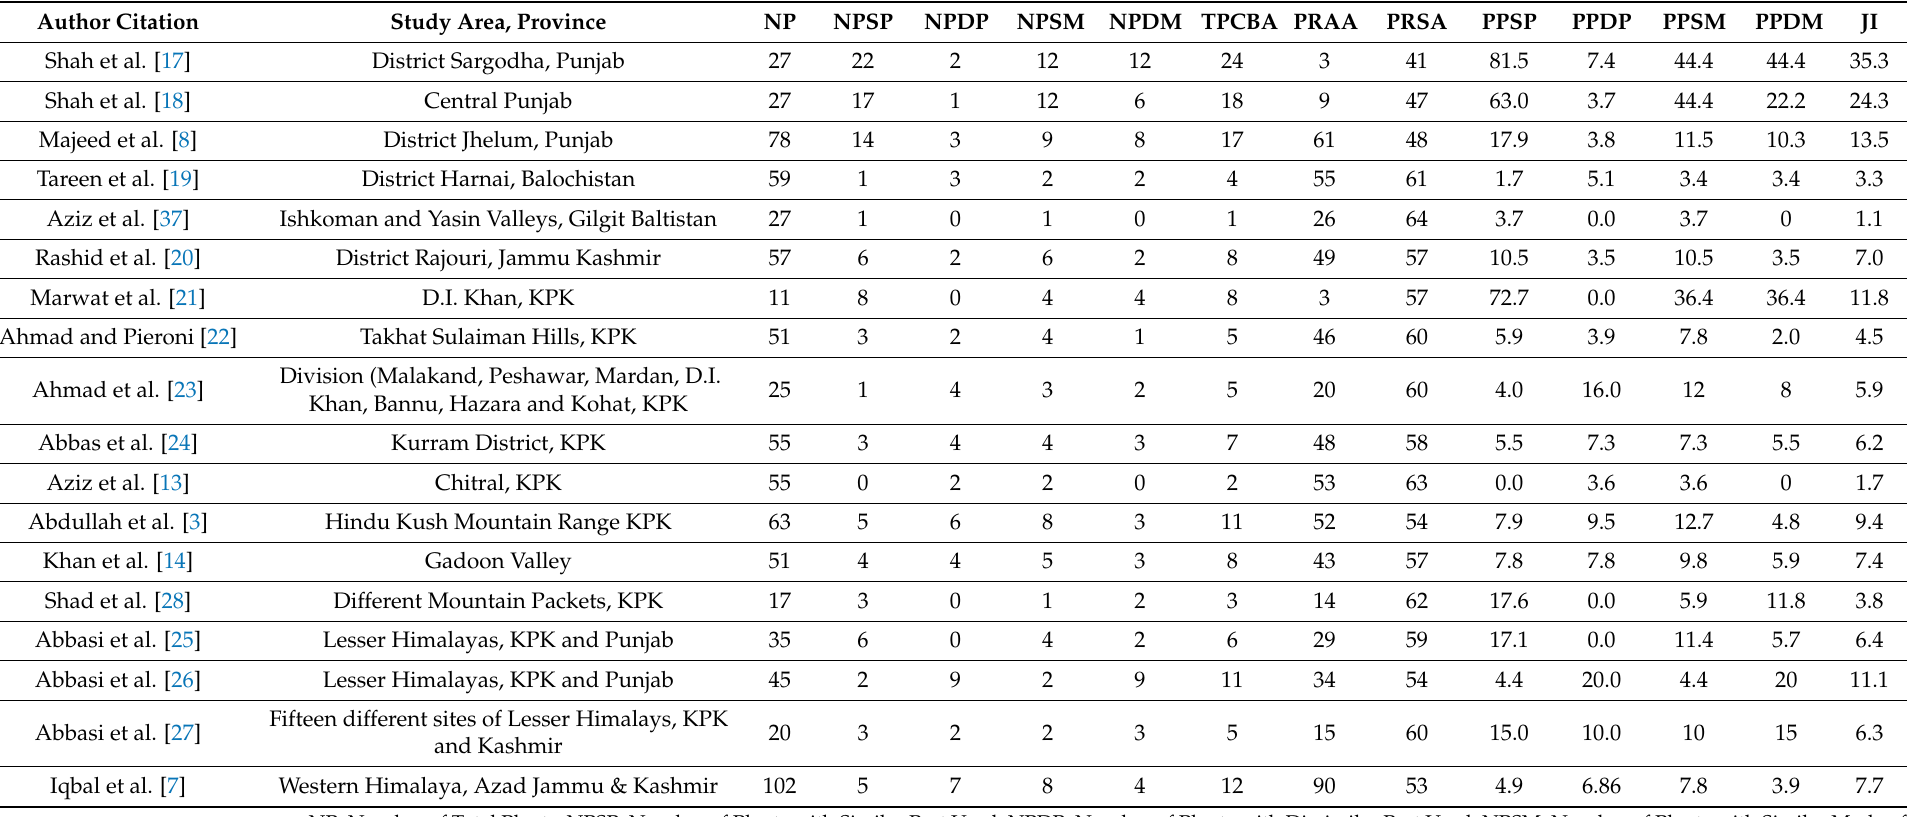
Table 3. Jaccard index comparing the present study with previous articles in the surrounding